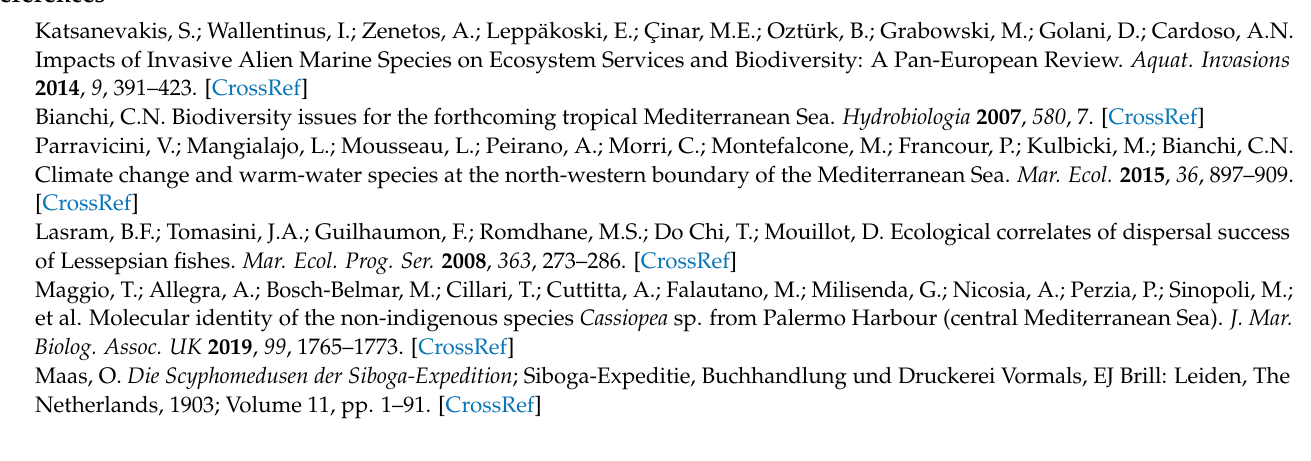
(a) temperature ( ◦ C), (b) salinity, and (c) transparency (%) in April 2018. The white triangles indicate the measurement points of the